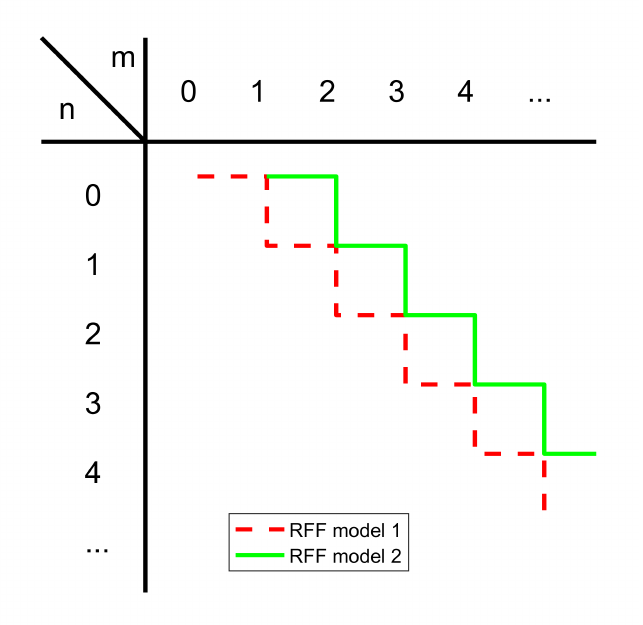
Figure 2. Order updating path of different RFF models in Algorithm 1.